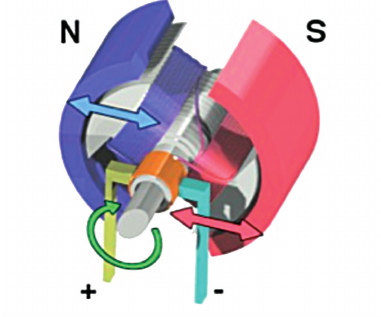
RQ-2 Pioneer (Valavanis 2007) two-stroke, two-cylinder Sachs engine in boxer Engine